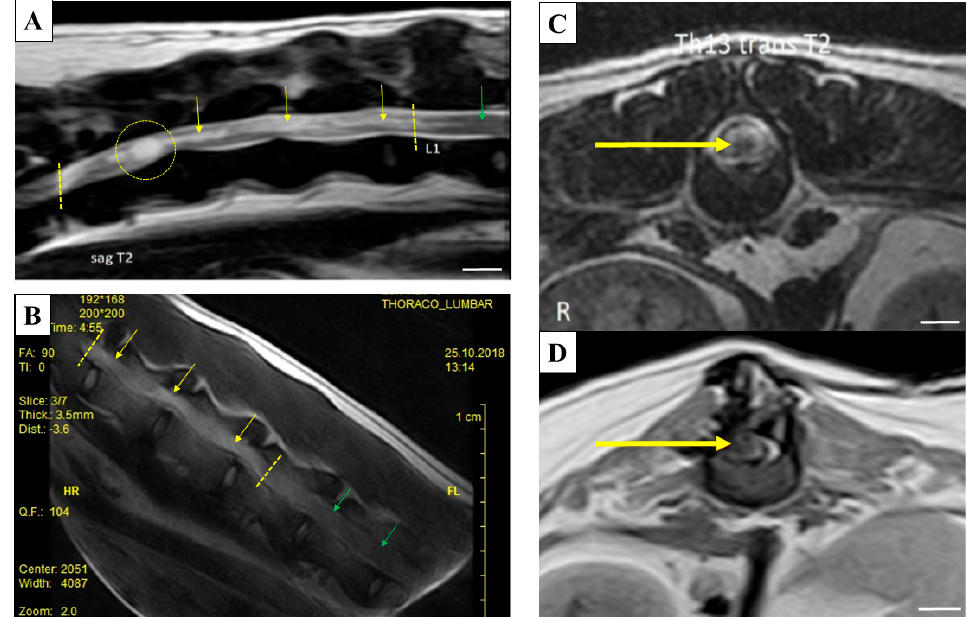
Figure 5. Magnetic resonance imaging (MRI) images of thoracolumbar segments of dogs with spinal cord injury (SCI). ( A ) Sagittal T2-weighted image of the thoracolumbar spine in Dog Z. Hyperintense diffused intramedullary lesion is visible from vertebra T11 to L1. At the level cranially to the T11–T12 intervertebral disc space there is a cyst-like lesion affecting the whole spinal cord diameter. ( B ) Sagittal SSE image of the thoracolumbar spine in Dog B. Hyperintense diffused intramedullary lesion is visible at the level from T13 to L2 vertebra. ( C ) Transversal T2-weighted image of Dog T spine at the level of T13 vertebra. Focal hyperintense intramedullary lesion with hypointense center is visible at the level of vertebra T13–L1 (yellow circle). ( D ) Transversal T1-weighted image of Dog M spine at the level of T12 vertebra. Focal hypointense intramedullary lesion is visible at the level of vertebra T11–T12. This lesion was also hyperintense on T2-weighted images (yellow arrows point to damaged spinal cord tissue, green arrows to normal tissue). Scale bars A, C and D = 1 cm.